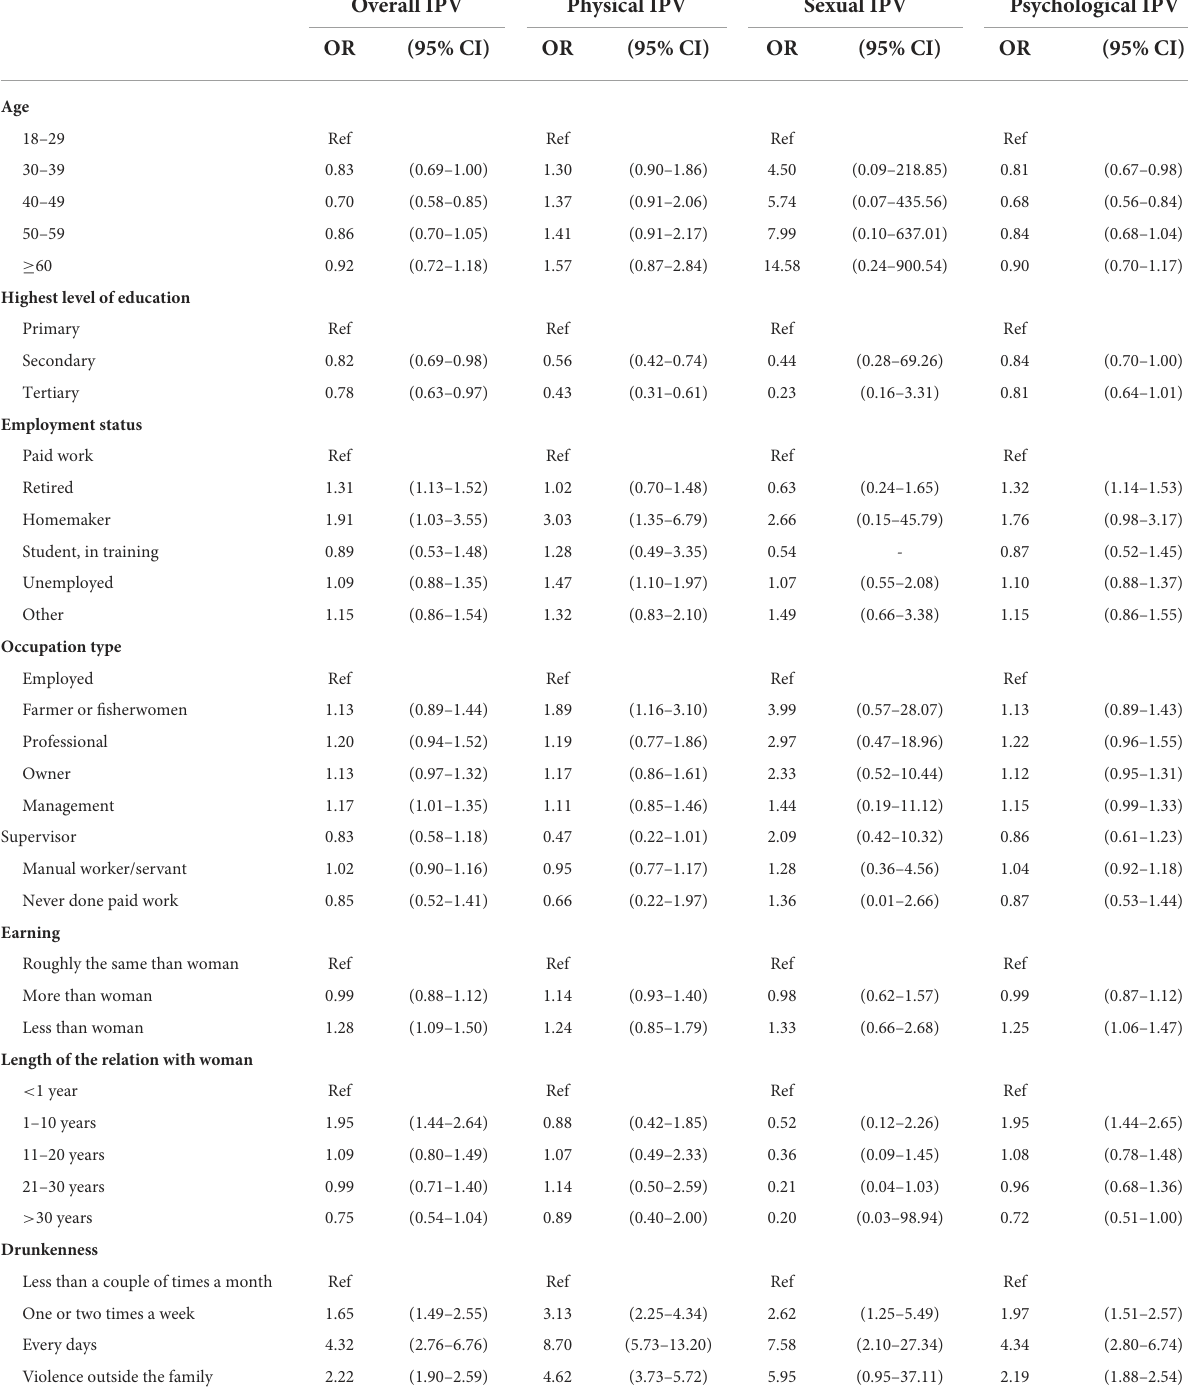
TABLE 6 Associations between overall, physical, sexual, and psychological intimate partner violence (IPV) and characteristics of current partners of IPV